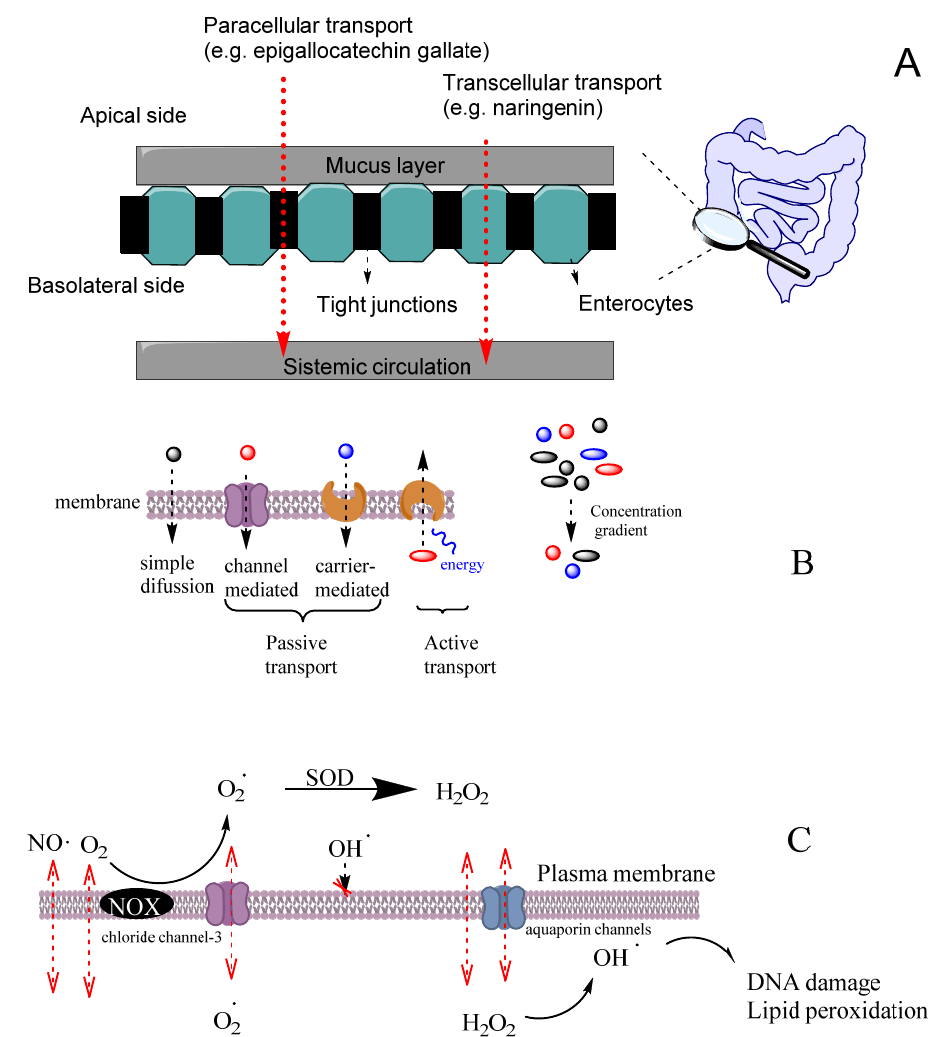
Figure 11. ( A ) Different transport pathways across the intestinal cell epithelium. Adapted from [69], Copyright (2022), with permission from Elsevier. ( B ) General types of membrane transport. ( C ) Permeability of lipid membranes to different reactive species [60–62]. Adapted from reference [60], Copyright (2022), with permission from Elsevier.